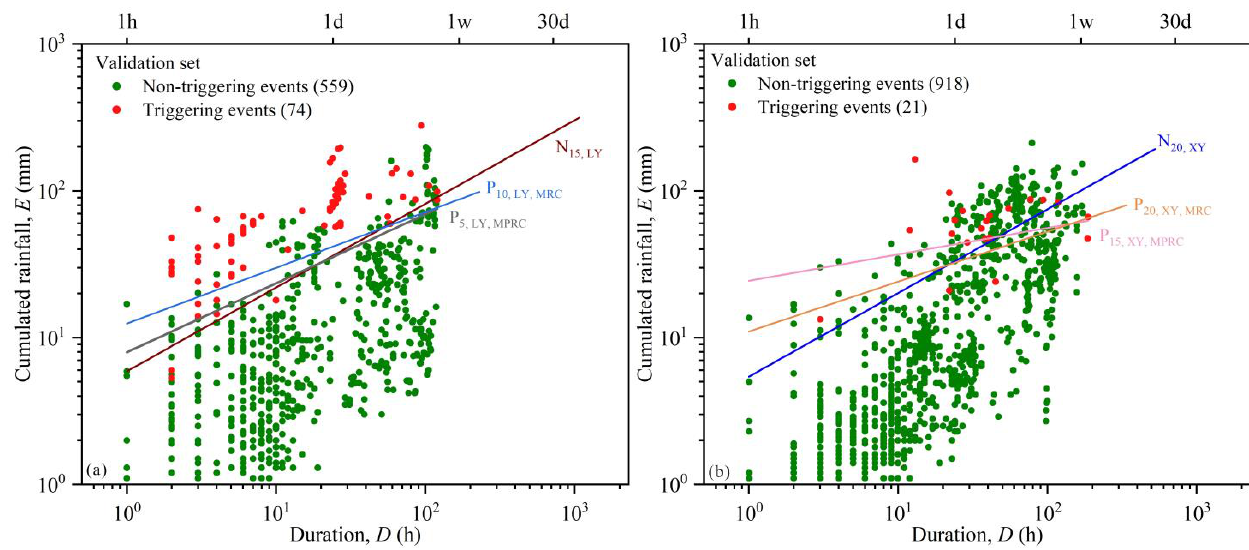
Figure 8. Validation set and best-performing rainfall thresholds: ( a ) LY county; ( b ) XY county. Tables 6 and 7 report the number of elements of the contingency matrices calculated Table 6. Number of elements of the contingency matrix calculated for the rainfall thresholds defined in LY. for the negative and the positive thresholds. The skill scores were derived from these ele- ments (Tables 8 and 9). For the LY case, the highest number of TP (71) is obtained consid- ering N 20,LY , although this results in a significant number of FP (92) when compared to the other thresholds. A better compromise is represented by N 15,LY and P 5,LY,MPRC , which allow achieving a high number of TP (70), both minimizing the number of FP (60 and 61, respec-